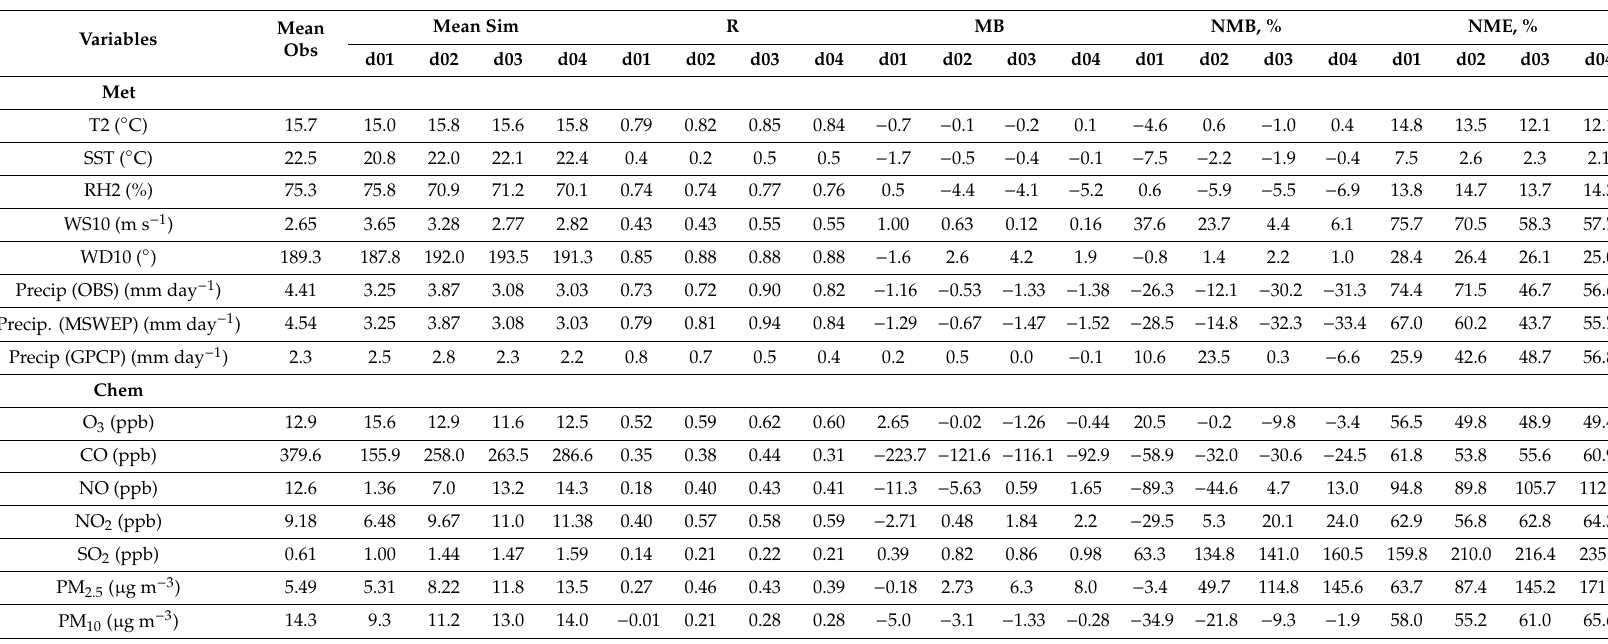
Table 2. Performance statistics of meteorological and chemical variables from WRF / Chem-ROMS simulations at a horizontal grid resolution of 81-km (in d01), 27-km (in d02), 9-km (in d03), and 3-km (in d04) calculated using predictions and observations in d04 for the SPS2 field campaign. Mean Variables